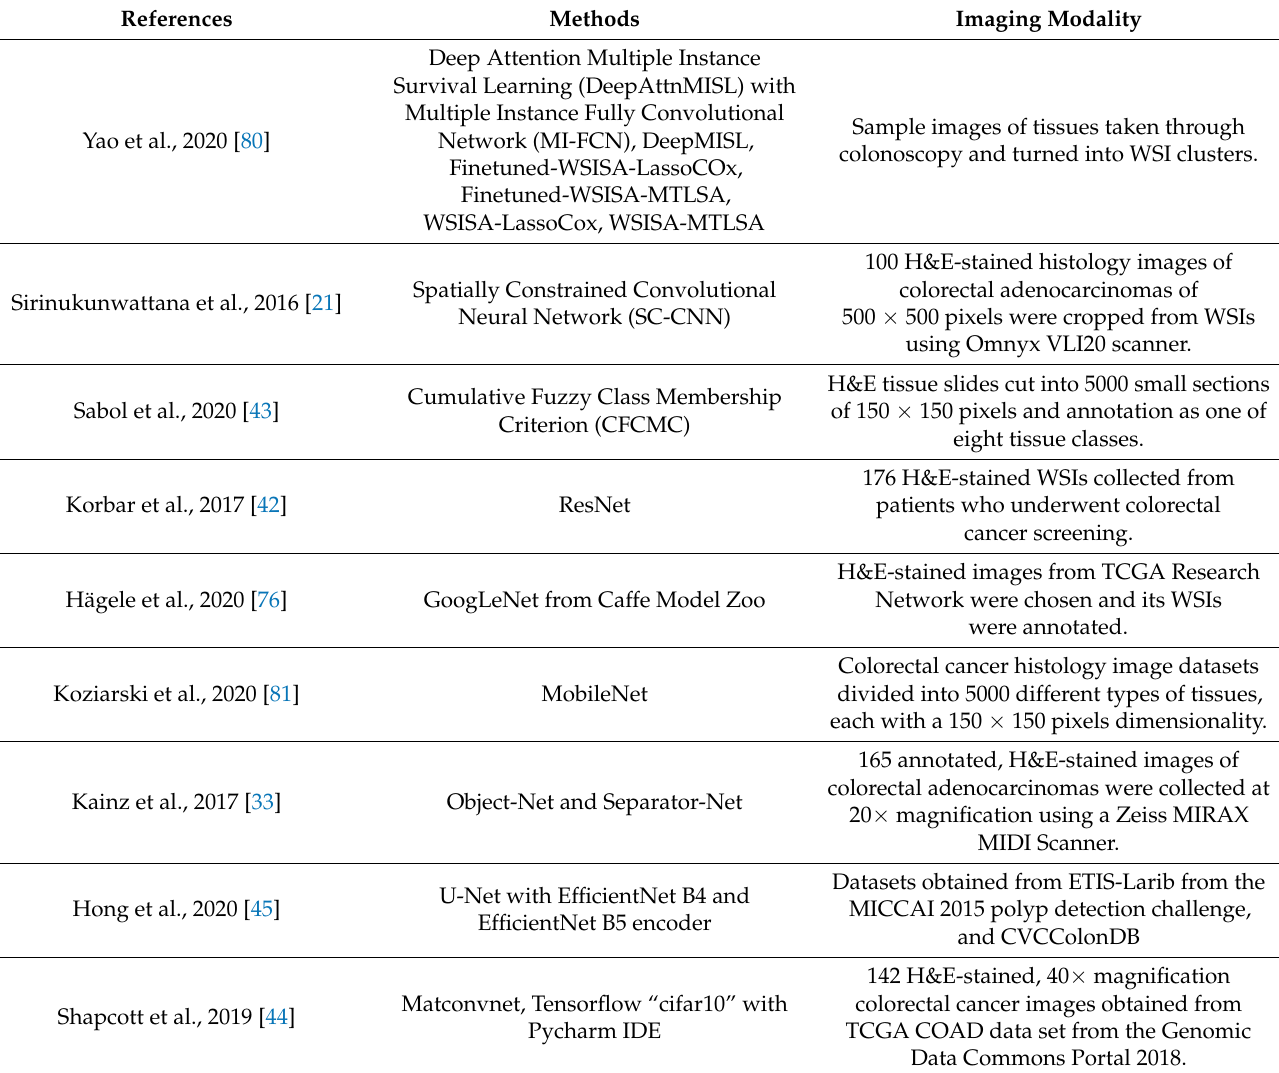
Table 1. General summary of studies related to explainable artificial intelligence and sampling methods using deep learning techniques for colon cancer